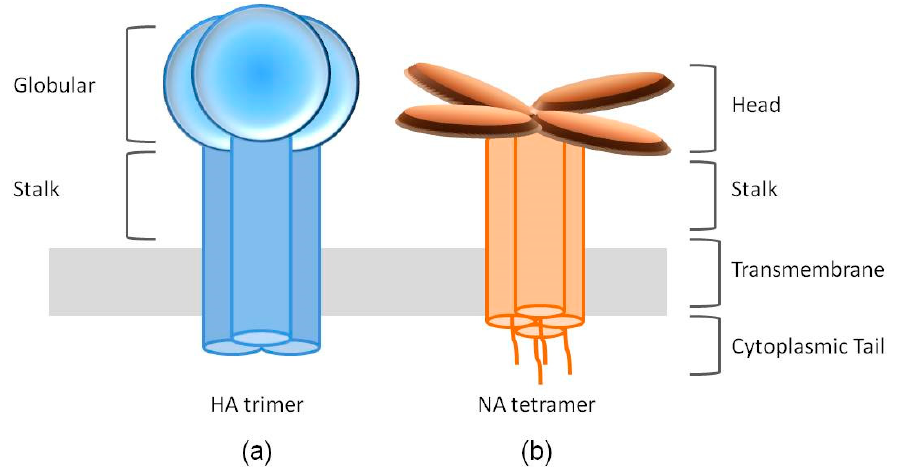
Figure 1. Cartoon structures of the spikes of hemagglutinin (HA) and neuraminidase (NA). ( a ) The HA spike is formed by an HA trimer. Each HA monomer contains two functional domains, the receptor binding globular domain and the helix-rich stalk domain. ( b ) NA exists as a tetramer of four identical monomers. Each NA monomer consists of four distinct structure domains, including the catalytic head, the stalk, the transmembrane region and the cytoplasmic tail.